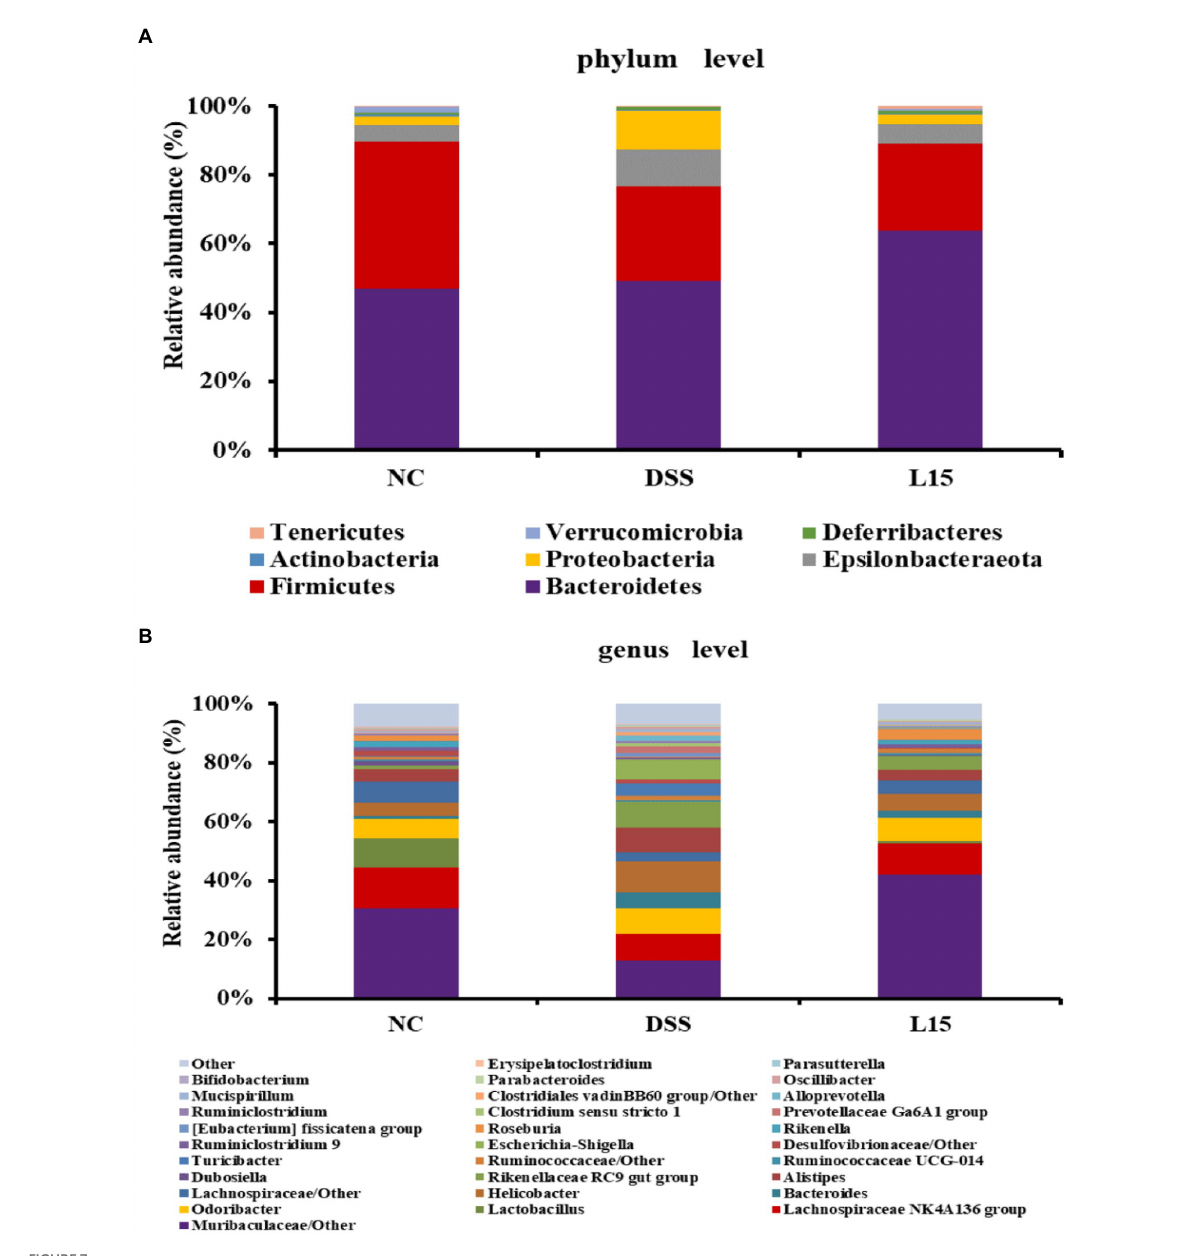
FIGURE 7 Gut microbial composition in analyzed mice fecal samples at the phylum (A) , and genus (B) levels. NC, normal control group; DSS, dextran sulfate sodium-induced colitis group; L15, Supplement L. plantarum L15